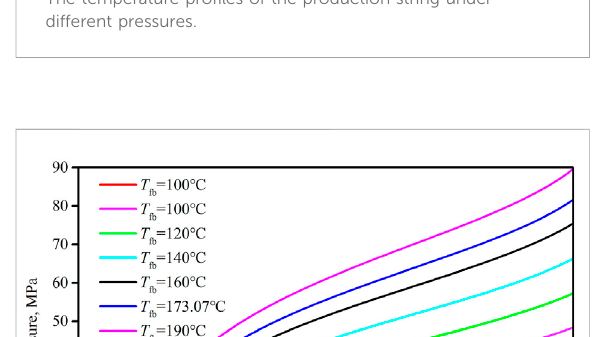
FIGURE 3 The changing law of annular pressure with the nitrogen gas column length under different production